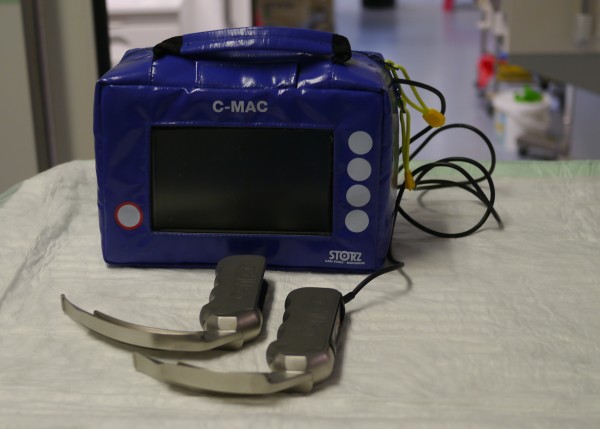
The C-MAC® video laryngoscope with size 3 and size 4 blades.